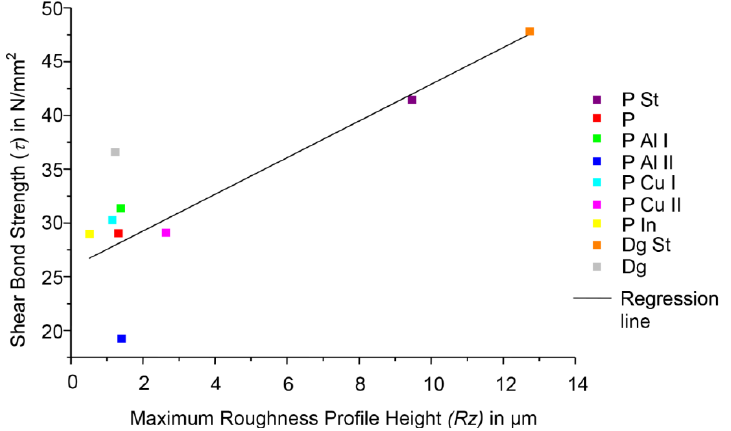
Figure 1. Correlation plot of the maximum roughness profile height vs. shear bond